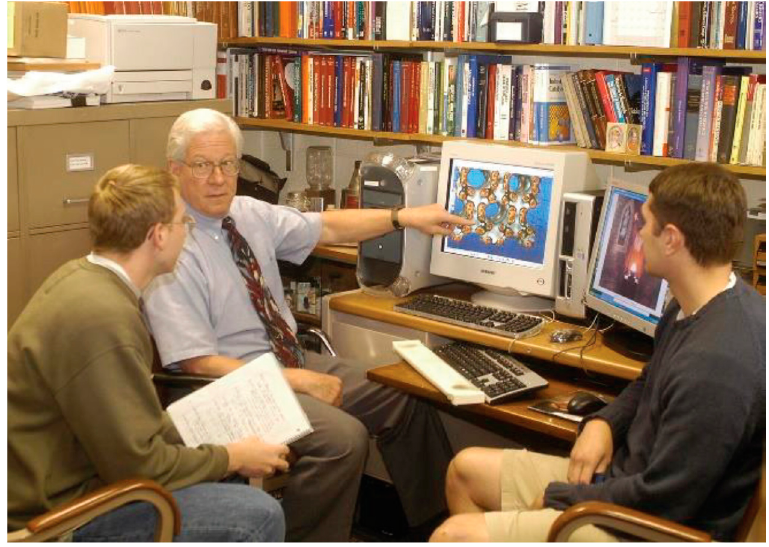
Figure 2. Professor Bartholomew with students.